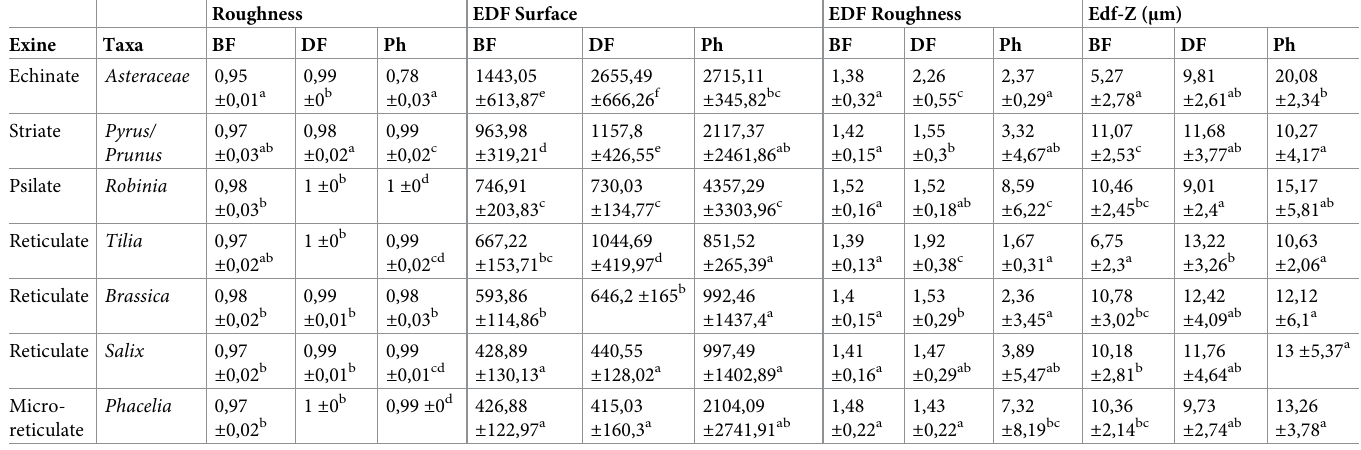
Table 7. Roughness and EDF